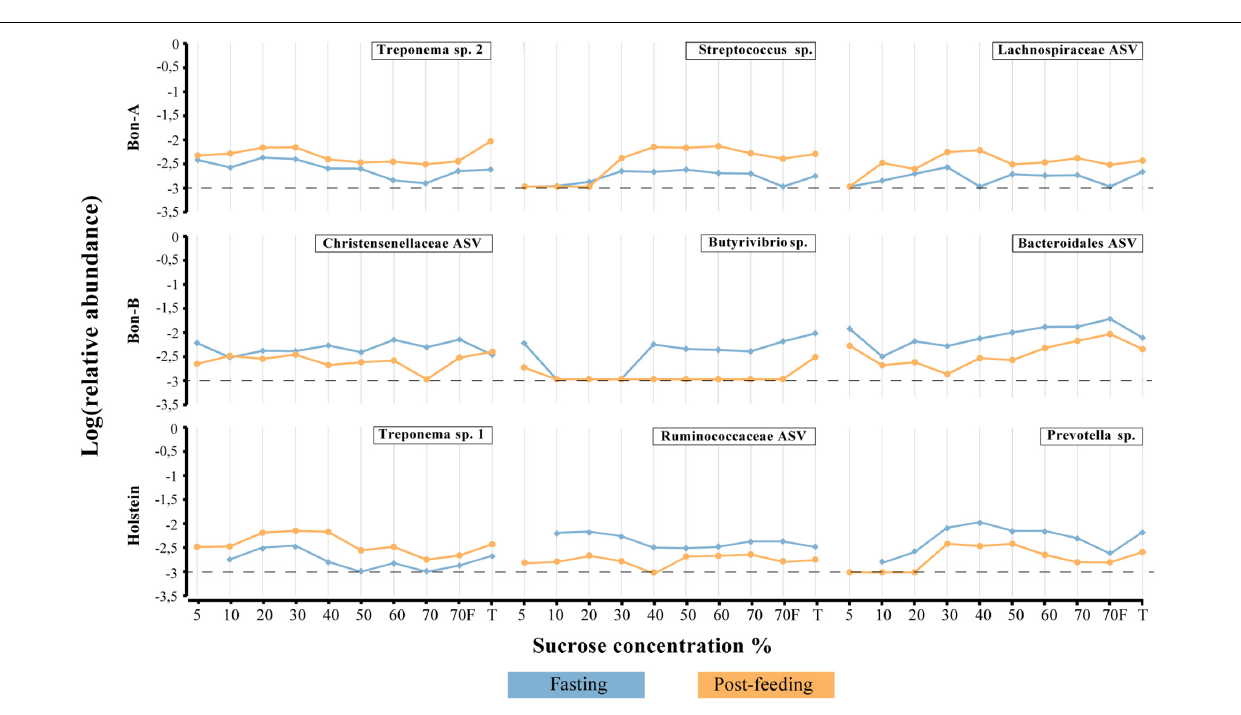
FIGURE 6 | Relative abundance of the ASVs that show their enrichment throughout all, or almost all, the fractions of the gradient. (A) BON-A, (B) BON-B, and (C) Holstein. Blue lines correspond to the relative abundance while fasting and orange are the abundances 1 h post-feeding. Dotted black line at − 3 represents a relative abundance of 1:1,000 which marks or limit of detection for the sequencing. The relative abundance was